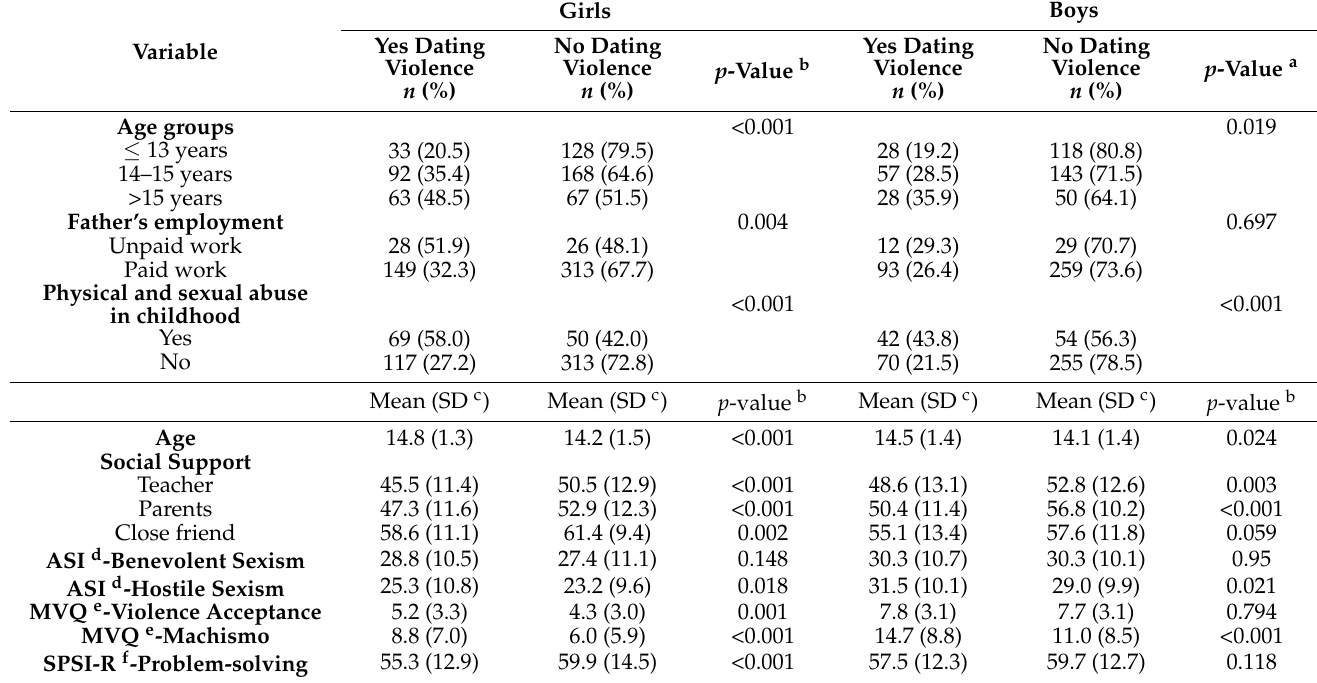
Table 2. Prevalence of Dating Violence According to Baseline Sample Main Characteristics, Alicante, Spain ( n = 255), Rome, Italy ( n = 285), Iasi, Romania ( n = 343), Matosinhos, Portugal ( n = 259), Poznan, Poland ( n = 190) and Cardiff, UK ( n = 204),